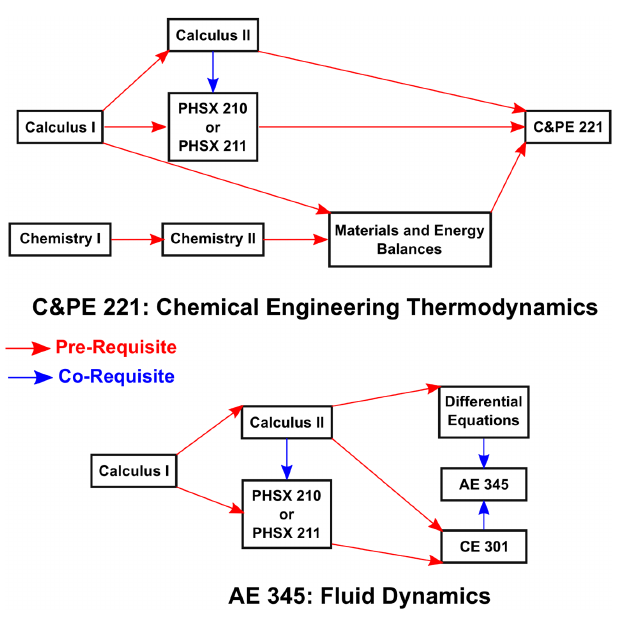
FIG. 9. The prerequisites and corequisites for C&PE 221 (Chemical Engineering Thermodynamics) and AE 345 (Fluid Dynamics).